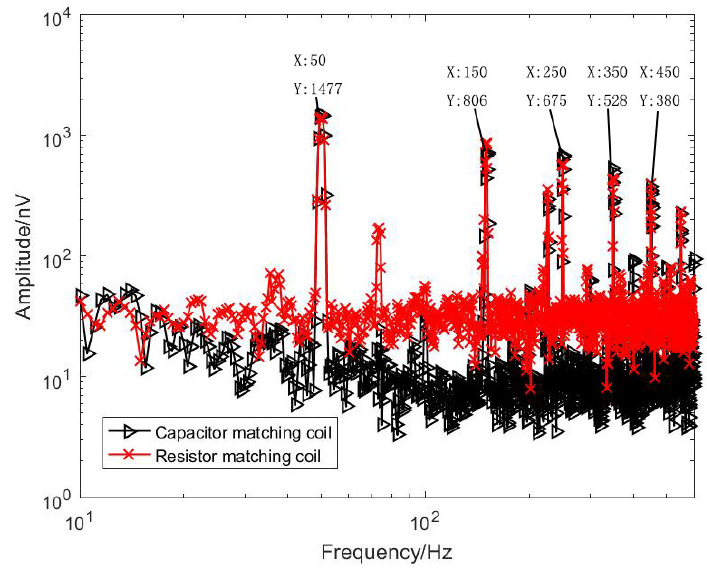
Figure 14. Two sensors measured data (test signal details). Sensors 2020 , 20 , 194